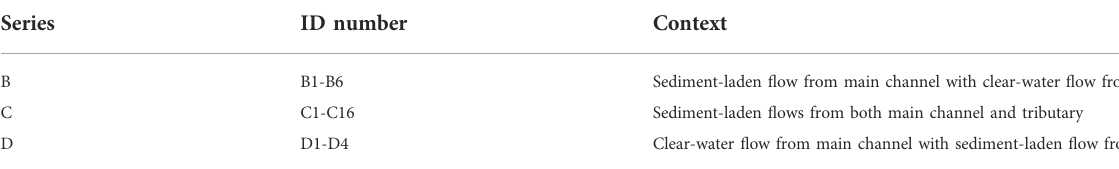
TABLE 1 Series of numerical cases of laboratory-scale con fl uence fl ows. Series